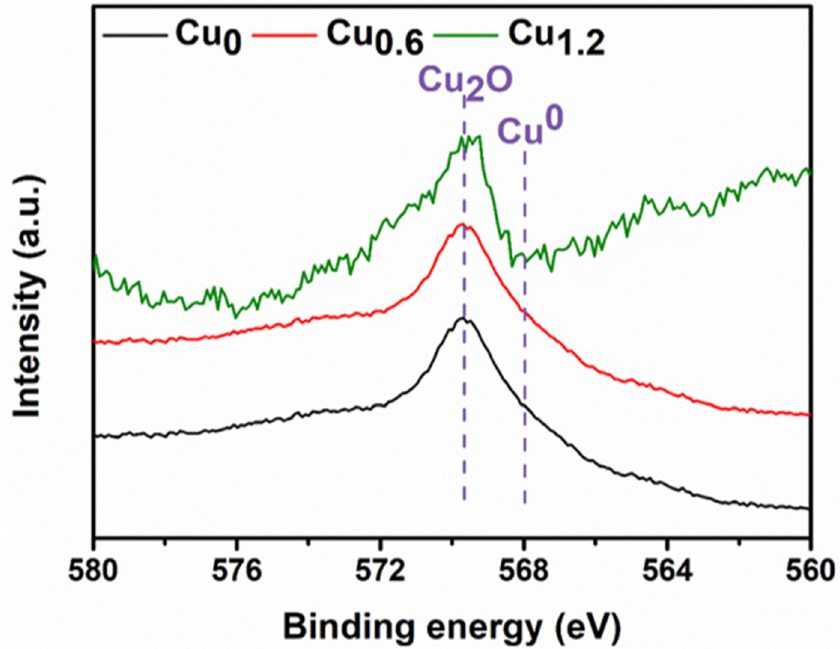
Figure 15. Cu LMM Auger energy spectra of Cu 0 (black), Cu 0.6 (red), Cu 1.2 (green) electrodes.